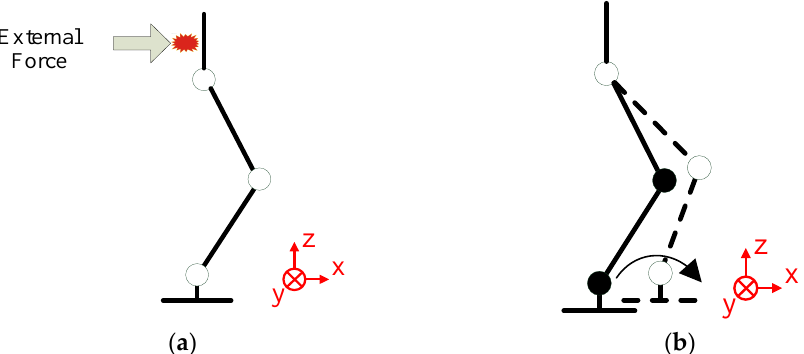
Figure 8. Two situations of the forward balance strategy. ( a ) The robot receives an external force from its back. ( b ) The left foot lifts and swings forward one step.